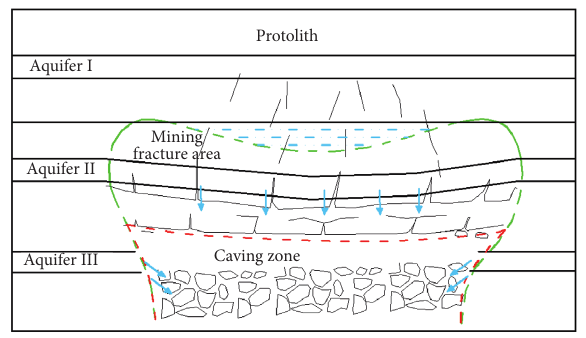
Figure 1: Rock mass fracture development